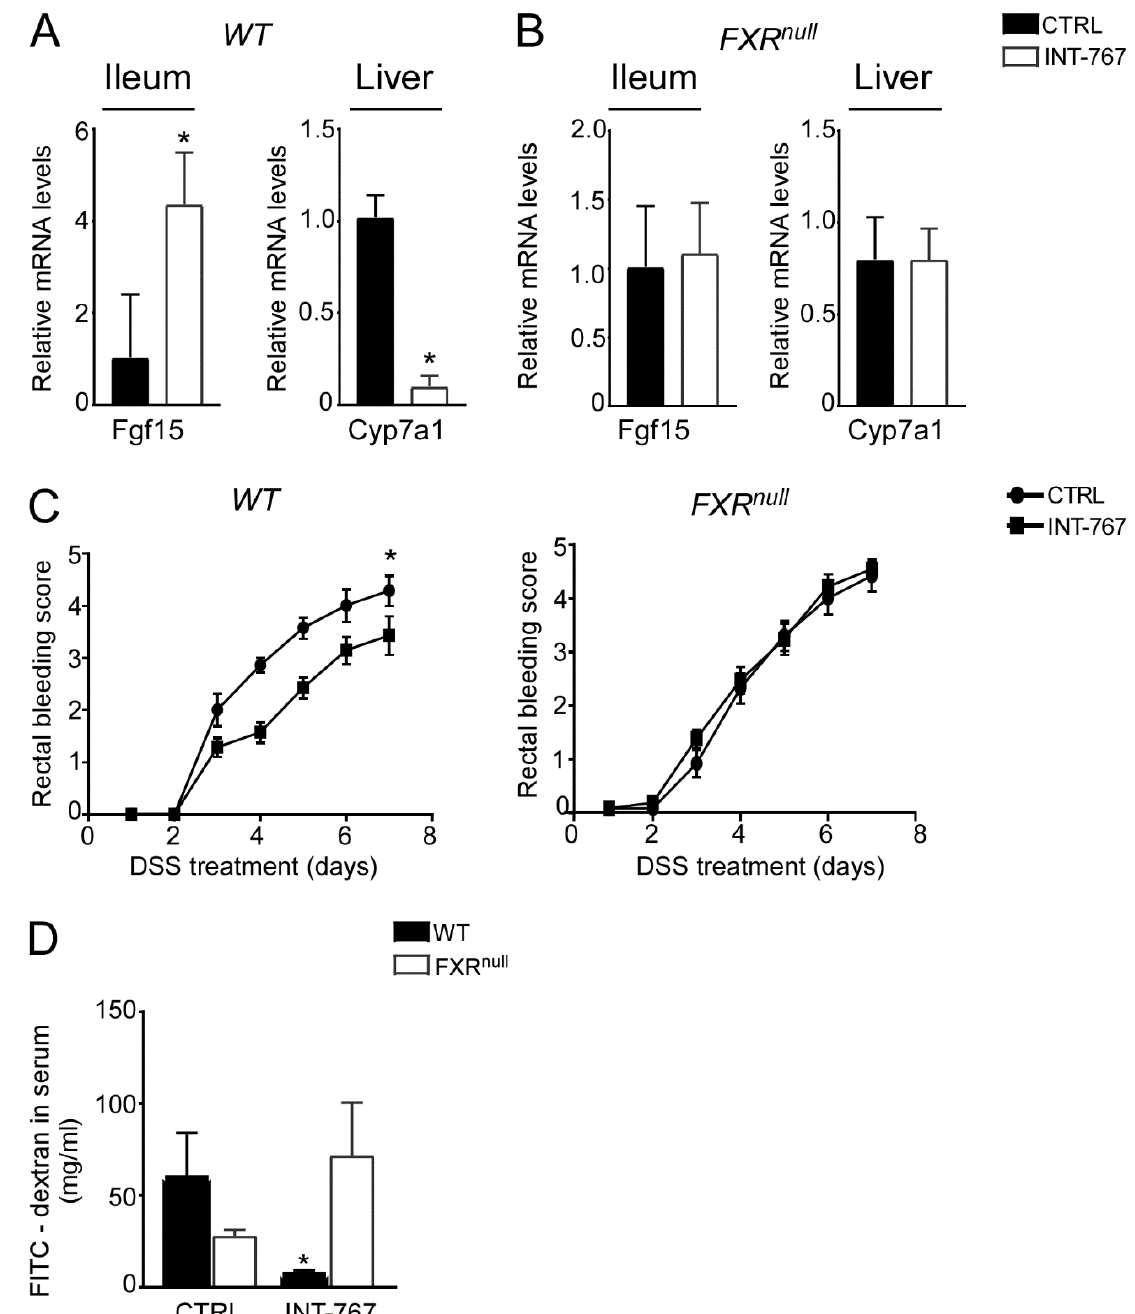
Figure 2. INT-767 protects from DSS-induced colitis via FXR activation. Gene expression analysis of FXR target genes in ( A ) WT and ( B ) Fxr null mice fed with or without INT-767 ( n = 7 WT CTRL and n = 7 WT INT-767; n = 6 Fxr null CTRL and n = 7 Fxr null INT-767). Cyclophilin was used as a housekeeping gene to normalize data. ( C ) Visible rectal bleeding score in WT and Fxr null mice fed with or without INT-767. ( D ) In vivo intestinal permeability measurement after DSS-treatment in WT and Fxr null mice assessed through FITC administration. All values are represented as means ± SEM ( n = 7 WT CTRL and n = 7 WT INT-767; n = 7 Fxr null CTRL and n = 7 Fxr null INT-767). Statistical significance was assessed by Student’s t -test (* p < 0.05).